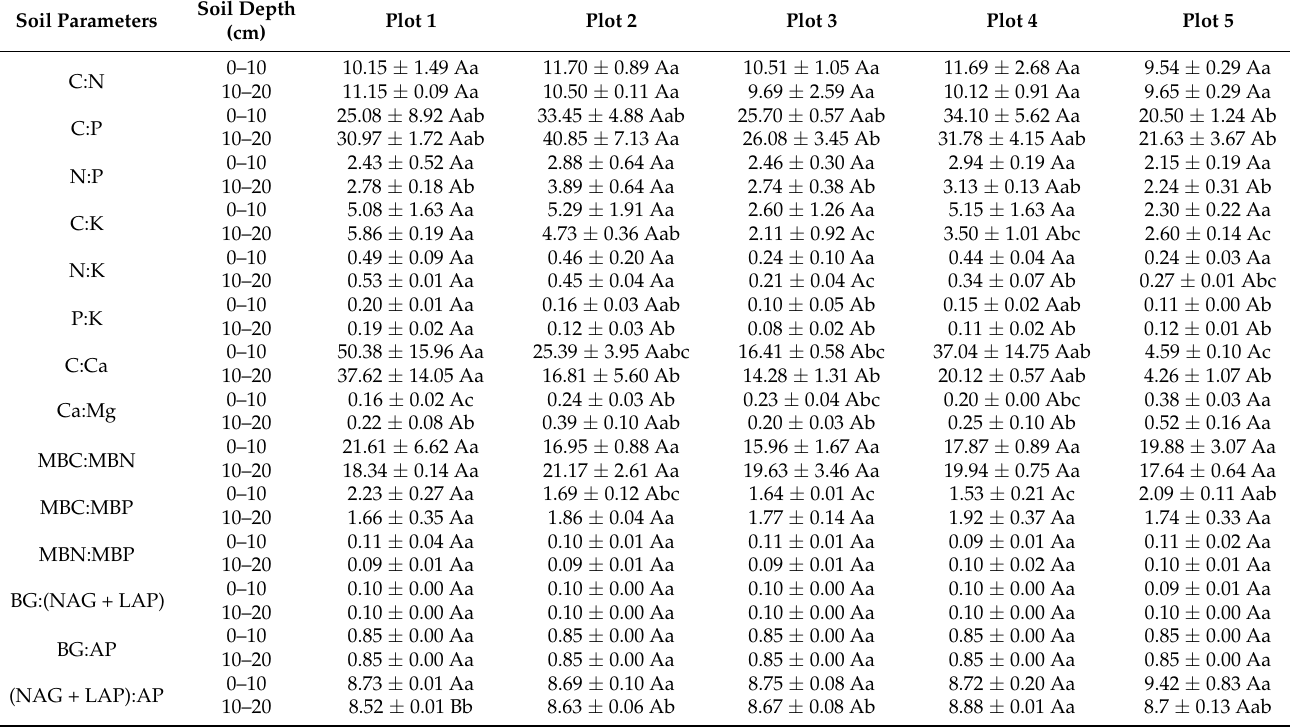
Table 6. Soil stoichiometric characteristics of Z. planispinum plantations with different planting combinations.